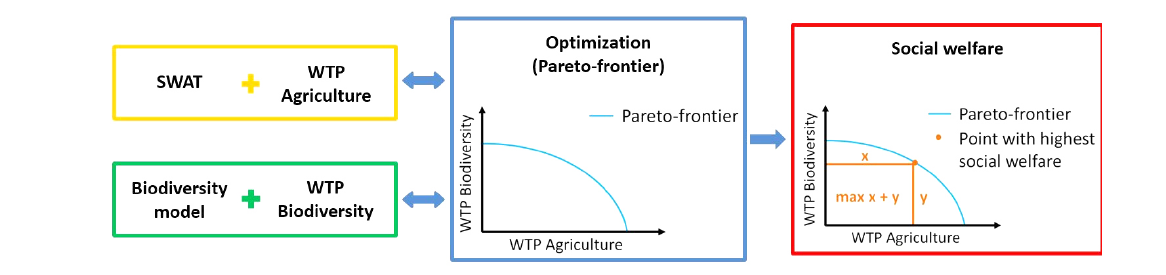
Fig. 1. Methodological framework for the analysis. The biophysical models for agricultural production and biodiversity are coupled with their respective willingness to pay (WTP) and interact with the optimization algorithm. From the resulting set of nondominated solutions (Pareto frontier), the solution with the highest sum of both WTP categories creates the highest contribution to social welfare, taking into account the biophysical potential of the